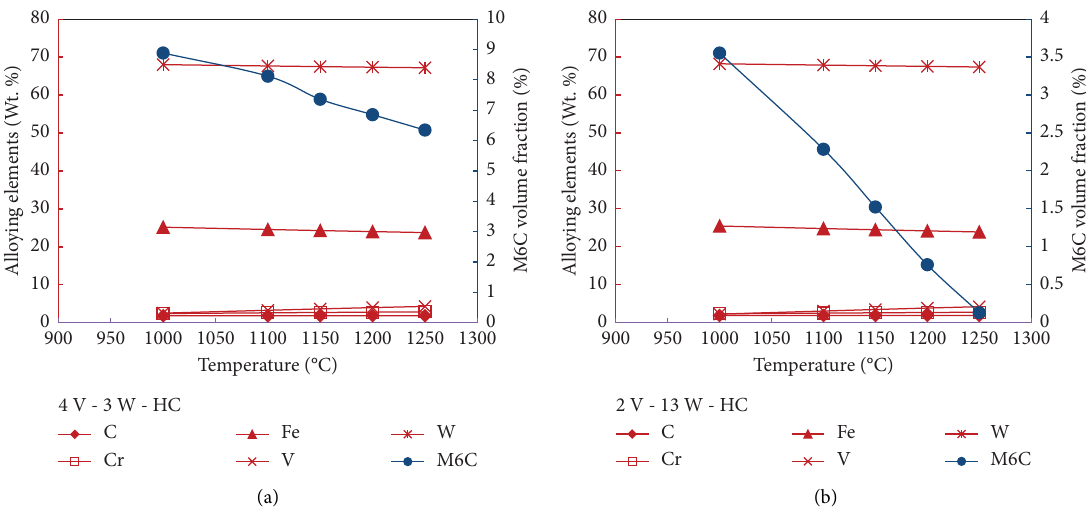
Figure 16: Chemical composition and the volume fraction of M 6 C carbide presented in vanadium with extra carbon-modifed steel at diferent austenitization temperatures. (a) 2V-13W-HC and (b) 3V-8W.